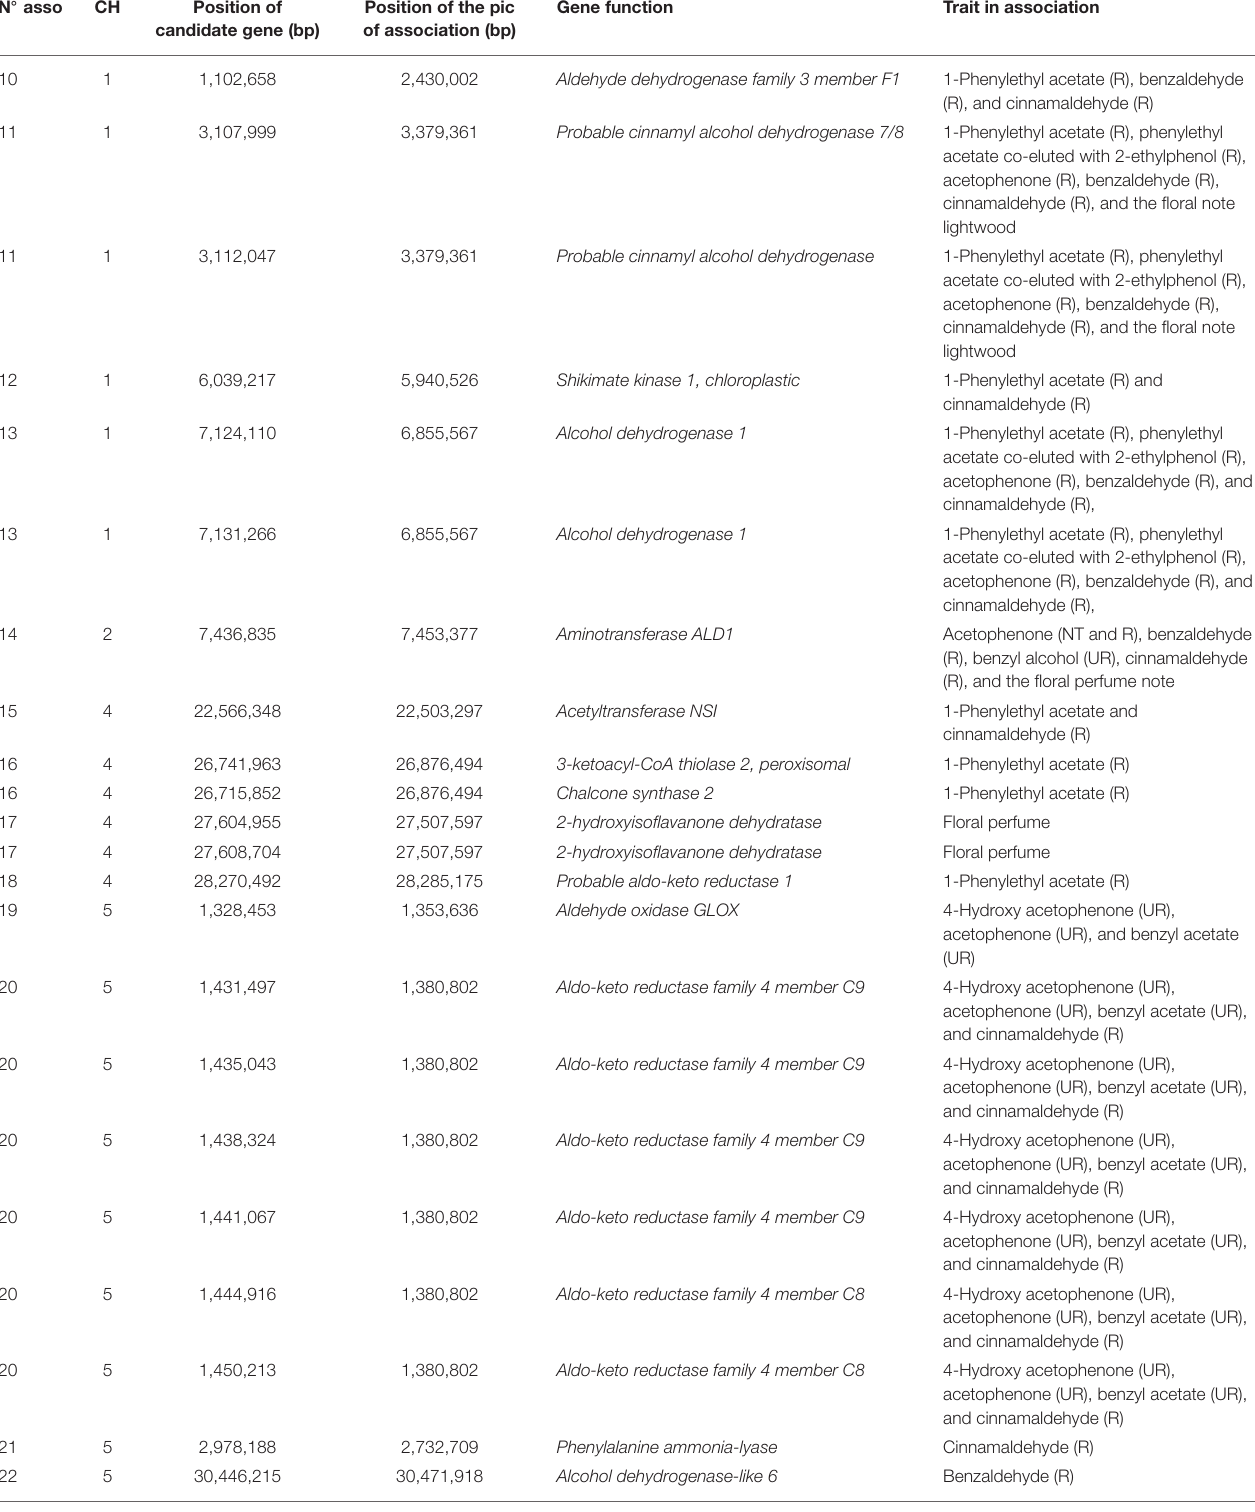
TABLE 7 | Candidate genes identified for L-phenylalanine degradation pathway. N ◦